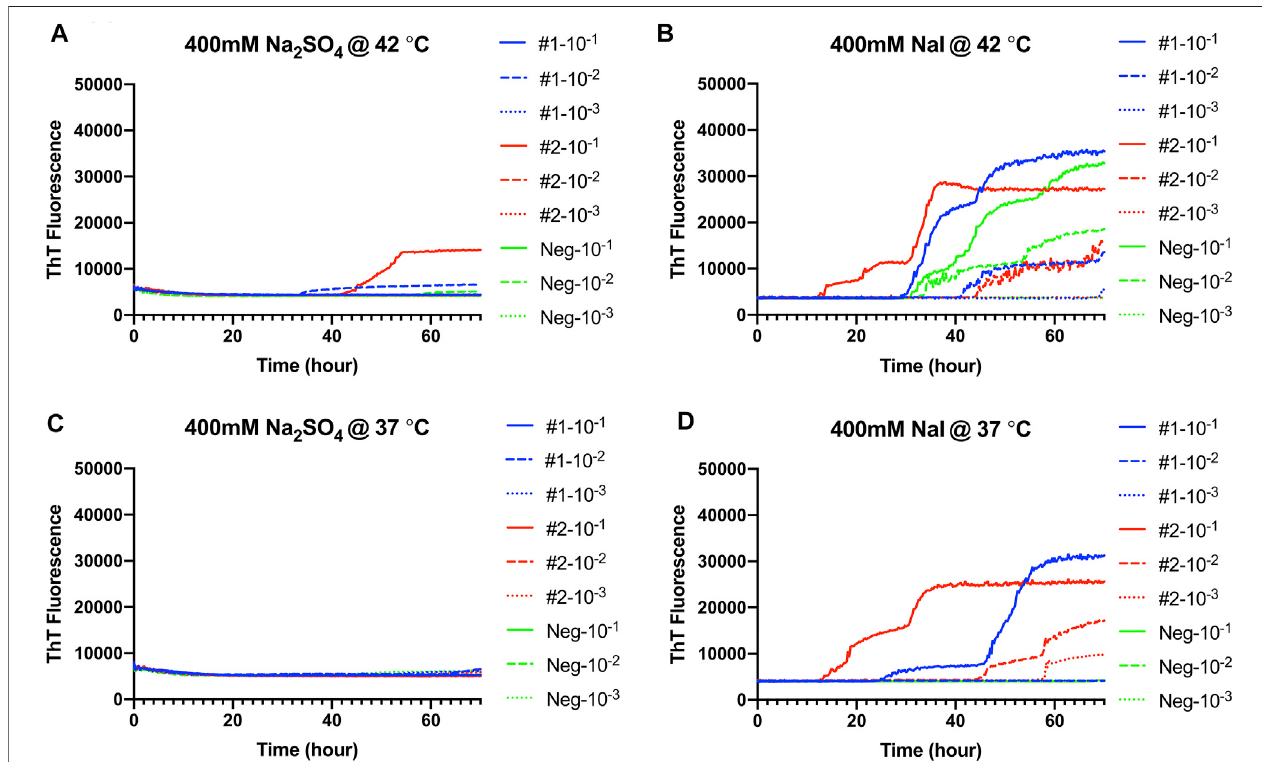
FIGURE 7 | Representative Hofmeister ion effects on RT-QuIC reactions seeded with CWD-positive white-tailed deer feces using the BV rPrP substrate. RT-QuIC reactions were seeded with 10 − 1 , 10 − 2 , or 10 − 3 dilutions of fecal homogenate from two CWD-positive and one CWD-negative white-tailed deer with the addition of 0.001% of SDS. Substrate contained bank vole rPrP and 400 mM Na 2 SO 4 (A,C) or NaI (B,D) . Reactions were run at 42 ° C (A,B) or 37 ° C (C,D) . Data are presented as mean ThT fl uorescence of four repeated